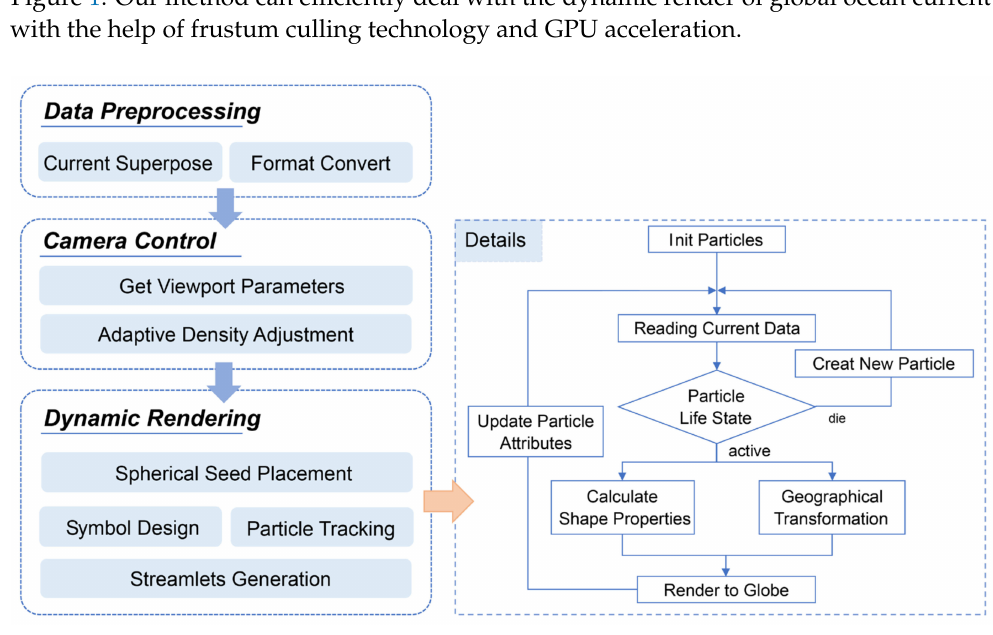
Figure 1. Overview diagram for multi-hierarchy dynamic